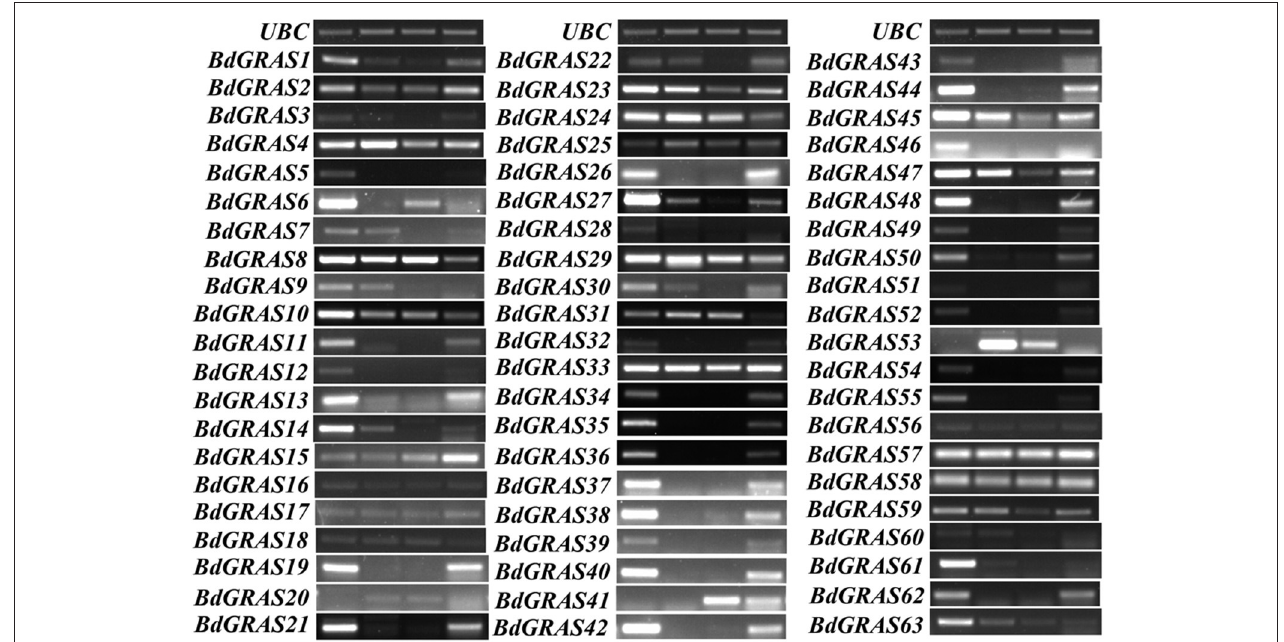
hormone treatment. After IAA treatment, the expression levels of most GRAS genes significantly reduced. The expression of BdGRAS34 , BdGRAS36 , BdGRAS37 , BdGRAS38 , BdGRAS39 , BdGRAS40 , BdGRAS41 , BdGRAS42 , and BdGRAS45 was inhibited under all four different hormone treatments ( Figure 4 ).